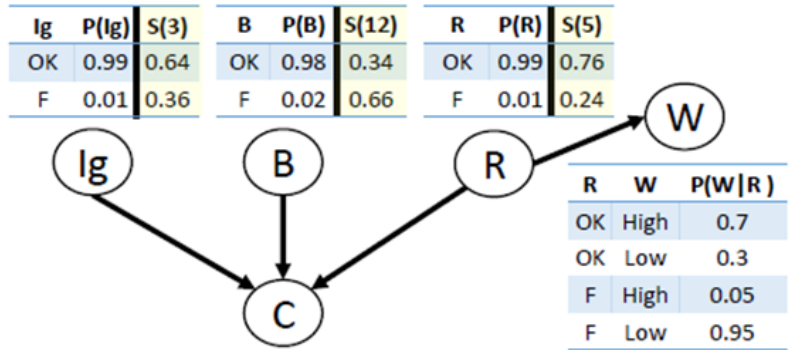
Figure 2. The BN for our car diagnosis running